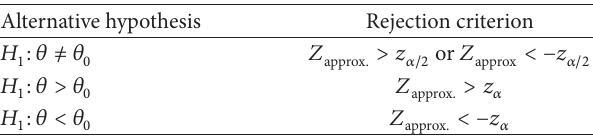
Alternative hypothesis Rejection